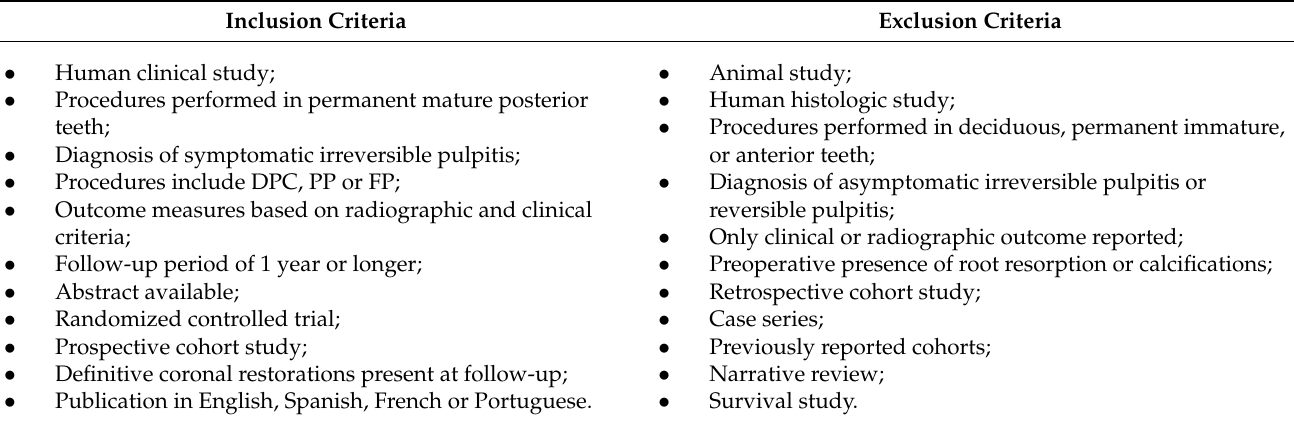
Table 1. Inclusion and exclusion criteria used to qualify studies for